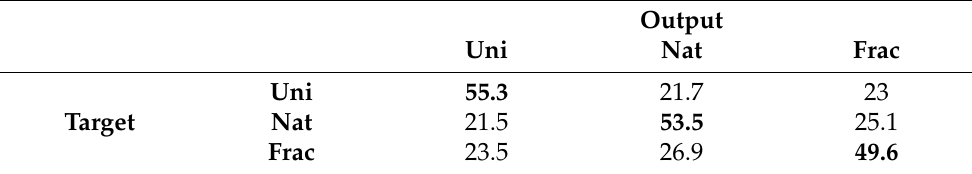
Table 1. Normalized mean confusion matrix (in %) for multi-class classification on the last